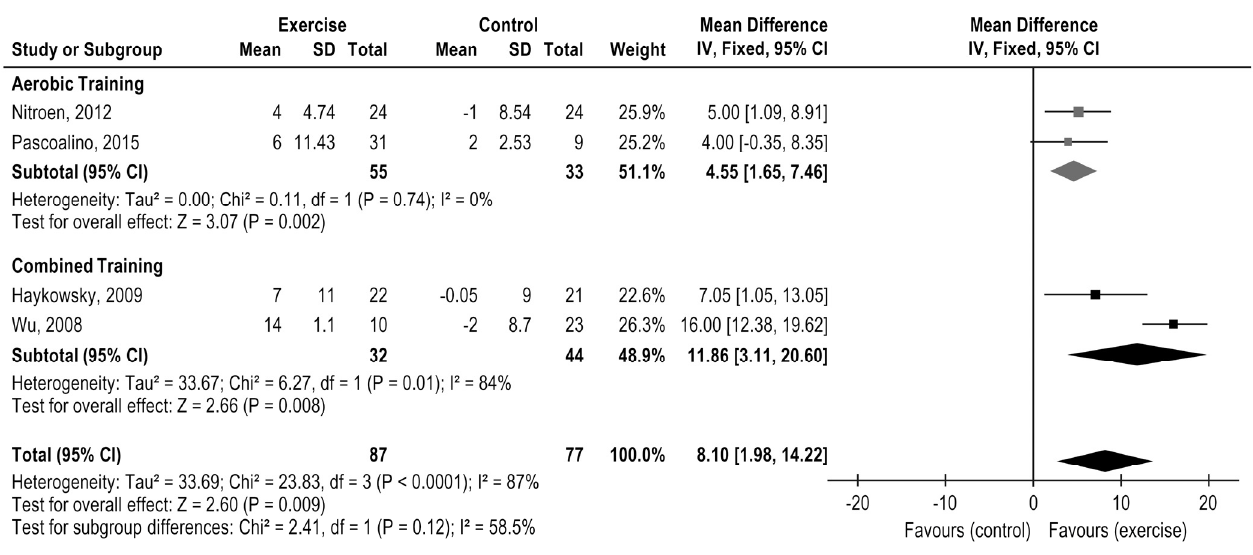
10 of 18 Figure 2. Impact of exercise training on V ′ O 2 peak (mL.kg.min) in HTx ( A ) exercise versus the control group ( B ) moderate continuous training and high-intensity training versus the control group ( C ) moderate continuous training versus high-intensity interval training. A greater V ′ O 2 peak increase were found for HIIT-AE (2 studies, n = 75 patients), MD = 4.43, 95% CI: 0.54 to 8.31 mL·kg·min − 1 , I 2 = 0%) than MCT-AE (4 studies, n = 112 patients), MD = 3.23, 95% CI: 1.94 to 4.52 mL·kg·min − 1 , I 2 = 0%, (Figure 2B) when both were compared to a control group. The HIIT superiority over MCT-AE was directly demonstrated when compared one versus another (2 studies, n = 110 patients) with a mean difference MD = 1.96, 95% CI: 0.99 to 2.93 mL kg − 1 min − 1 , I² = 0% (Figure 2C). 3.3. Exercise Effects on Peak Heart Rate